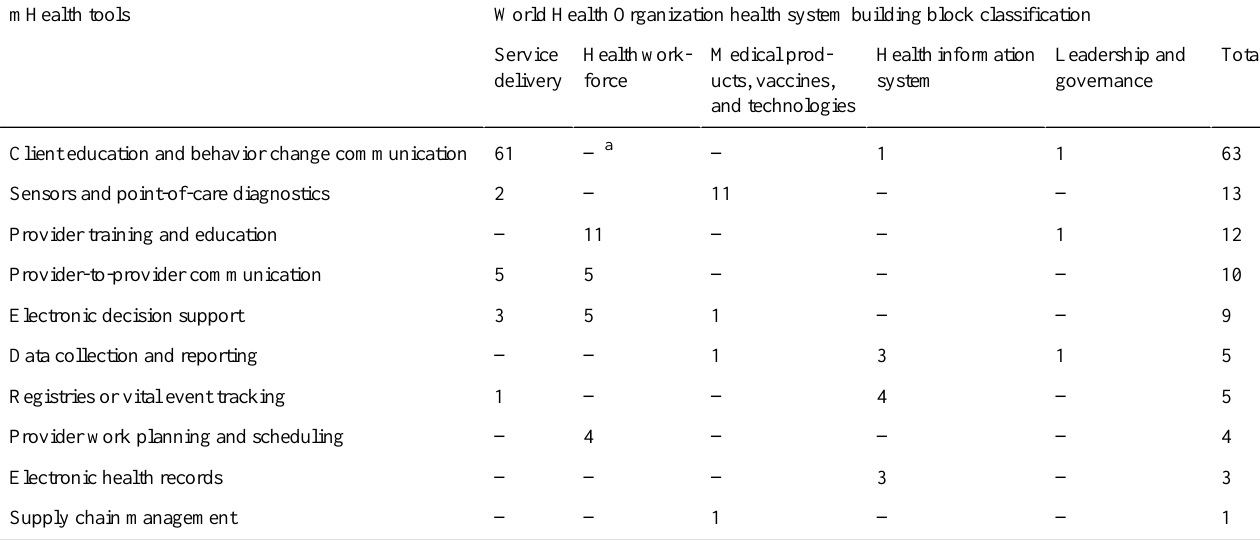
Table 3. Classification of the mHealth initiatives based on different health systems’building blocks and mHealth